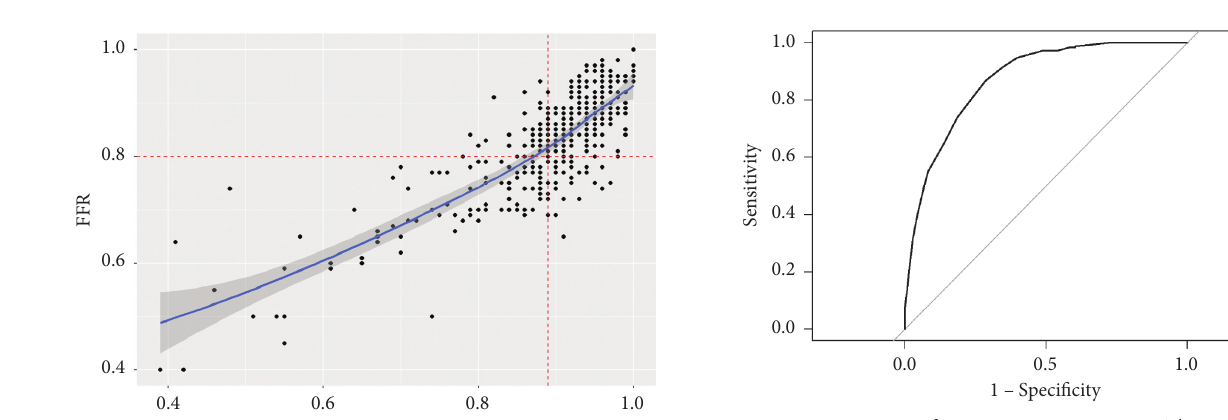
Figure 3: ROC curve of RFR versus FFR ≤ 0.80. The ROC curve showed an AUC of 0.873 (0.836–0.911; P < 0 . 001). The optimal cut- off point was RFR ≤ 0.88, showing a Youden index of 0.59 and